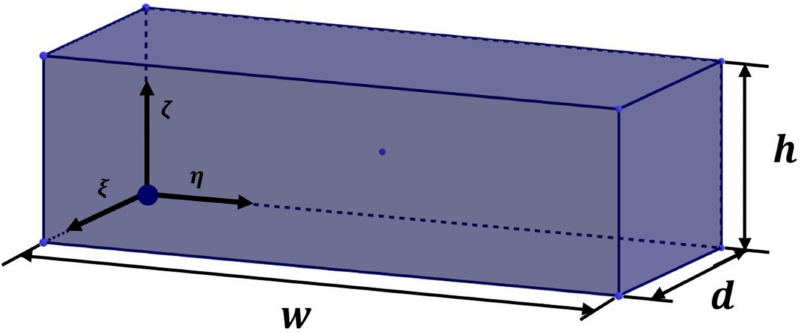
Figure 9. Description of the dimensions of a rectangular parallelepiped and the location of its local reference